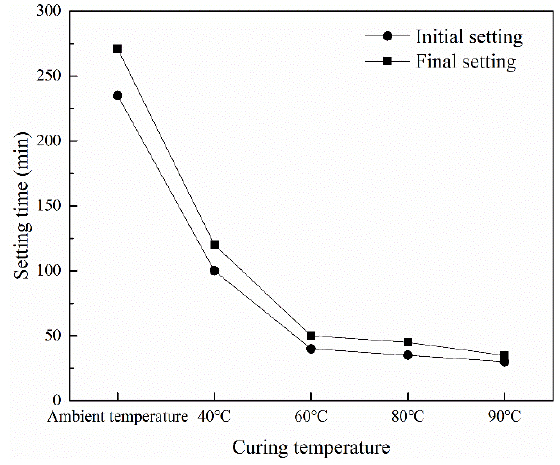
Figure 4. The setting time of HMGC at different temperatures.